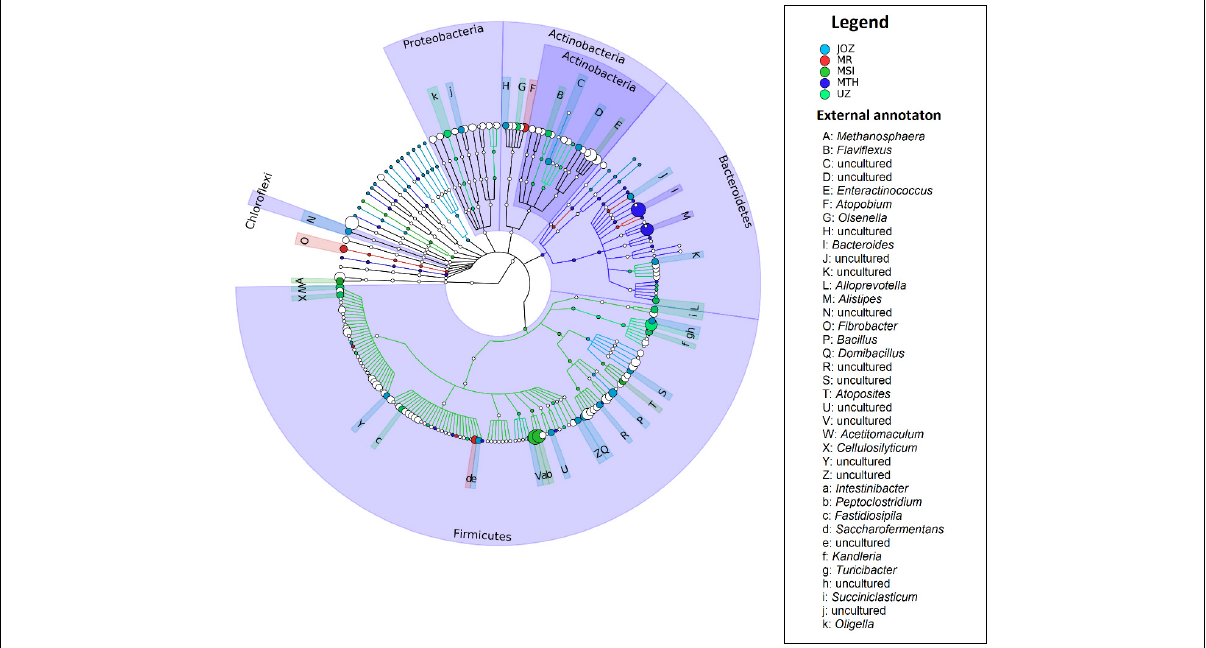
Figure 7: Differentially abundant bacterial phylotypes of Zulu sheep faeces across sites. Rings (from inside out) 1, 2, 3, 4, 5 and 6 are the domain, phylum, class, order, family and genus taxonomic ranks, respectively. Only features with a linear discriminatory analysis value > 2.0 are